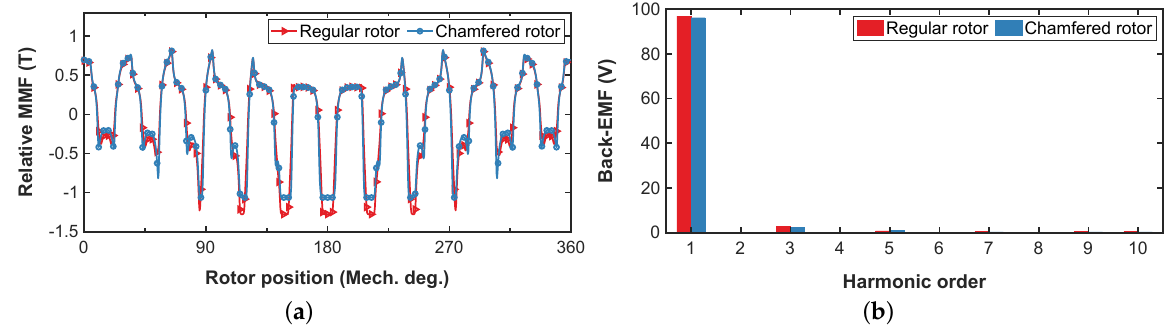
Rotor position (Mech. deg.)